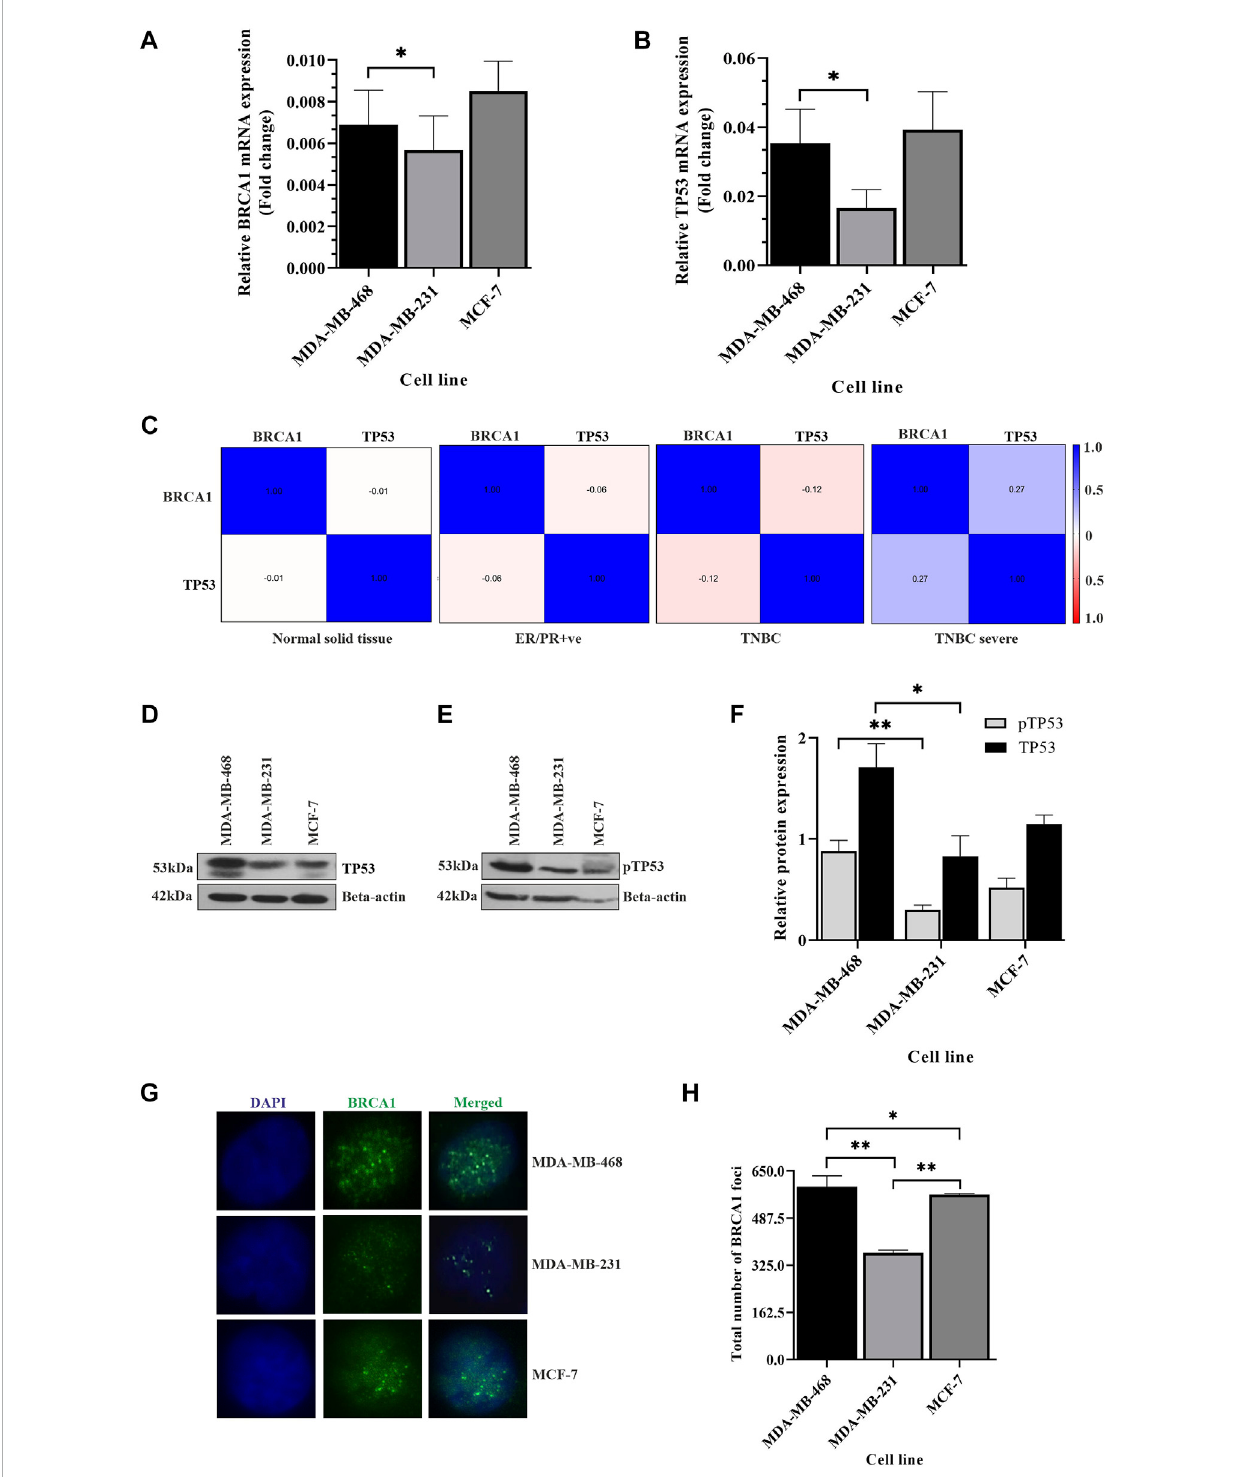
FIGURE 1 Differential expression of TP53 and BRCA1 within TNBC cells. (A,B) BRCA1 and TP53 expression changes with TNBC condition: The bar graph representstheexpressionstudiesperformedwithcDNA(500 ngofRNA)fromdifferentbreastcancerlines, TNBCcelllinesMDA-MB-468 andMDA-MB- 231,and luminal typeMCF-7.The expressionwasquanti fi edfromthetechnical triplicates oftheRTqPCR data. (C) Association of BRCA1and TP53 shows upinTNBCsevereconditiononly:associationbetweenBRCA1andTP53indifferentBCtissuesconditionsobtainedfromTCGAdataareanalyzedby correlogram. Moving toward darker blue color indicates an increase in positive correlation, whereas toward darker red indicates an increase in negative correlation.Thewhitecolorindicatesnocorrelation. (D,E) TP53anditsfunctioningarecompromisedinsomeTNBCconditionsonly:TP53expression,as well as its phosphorylation, was detected by western blot analysis of proteins extracted from the aforementioned cells, using corresponding (TP53 and phosphor-TP53)antibodies. β -Actinisgivenastheloadingcontrol. (F) Quanti fi